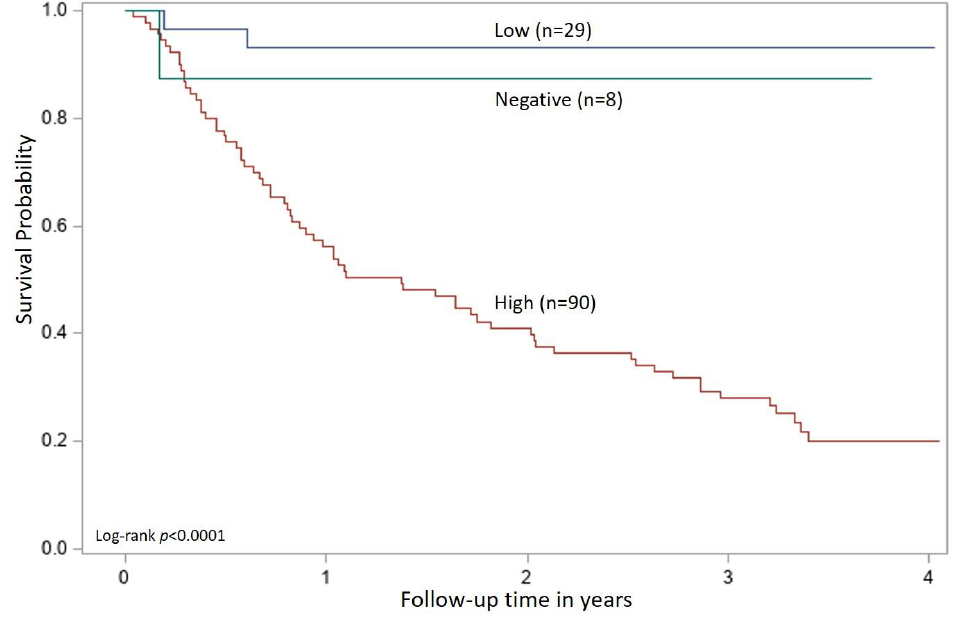
Figure 3. Kaplan–Meier survival curves for cats in the FeLV-positive group and categorized as low positive (Low), high positive (High), or presumed-negative (Negative). Each cat was categorized by applying the cutoff values from the ROC analysis to the test results obtained at the time of enrollment (time 0).